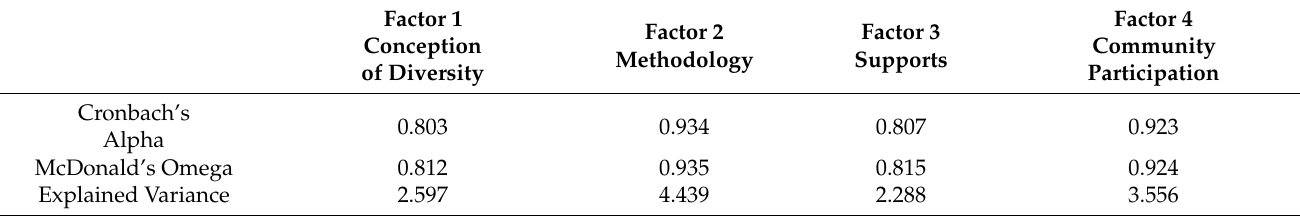
Table 7. Internal consistency of the CEFI-R